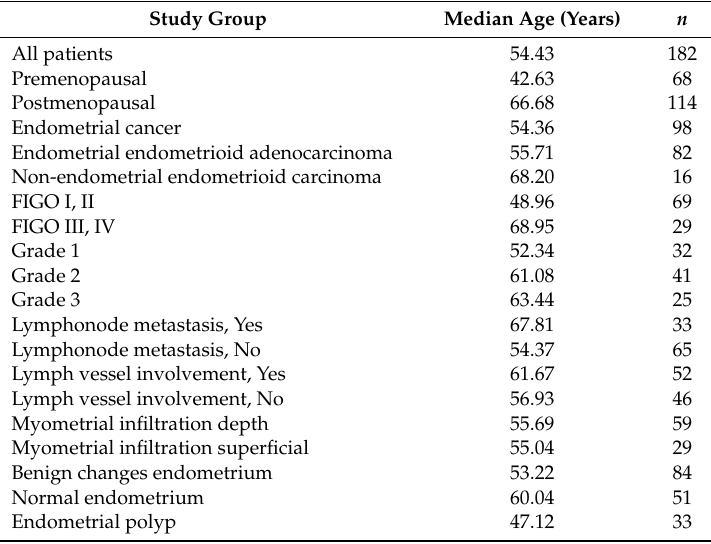
Table 2. Distribution of patients into subgroups.